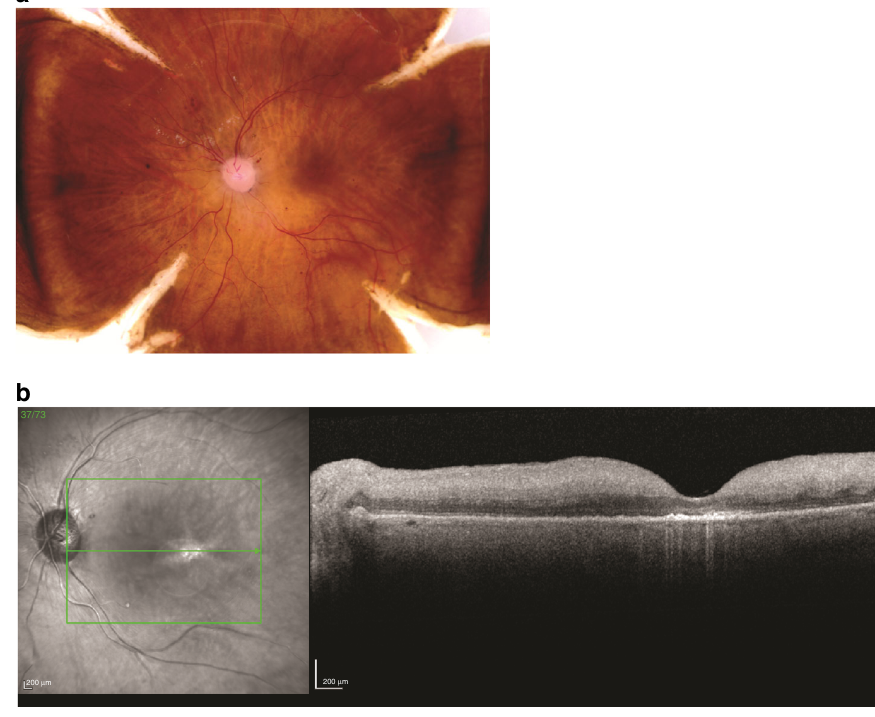
Fig. 1 Analogous color fundus and OCT images demonstrating normal fi ndings for post-mortem eyes. a Color fundus imaging of post-mortem retina showing a normal phenotype. b OCT image of post-mortem retina showing a normal phenotype.